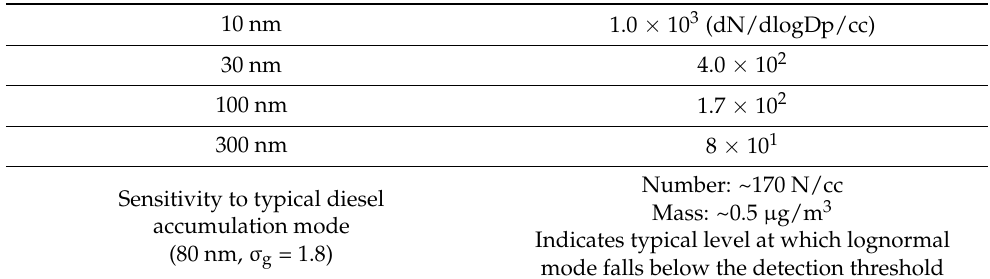
Table 3. DMS 500 sensitivity (RMS at 1 Hz) according to the particle diameters.